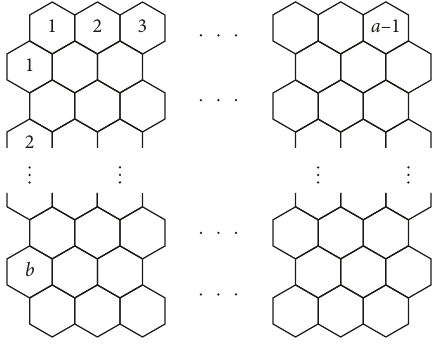
Figure 3: Benzenoid jagged-rectangle Table 3: Topological indices of jagged-rectangle benzenoid system for different values of p and q .